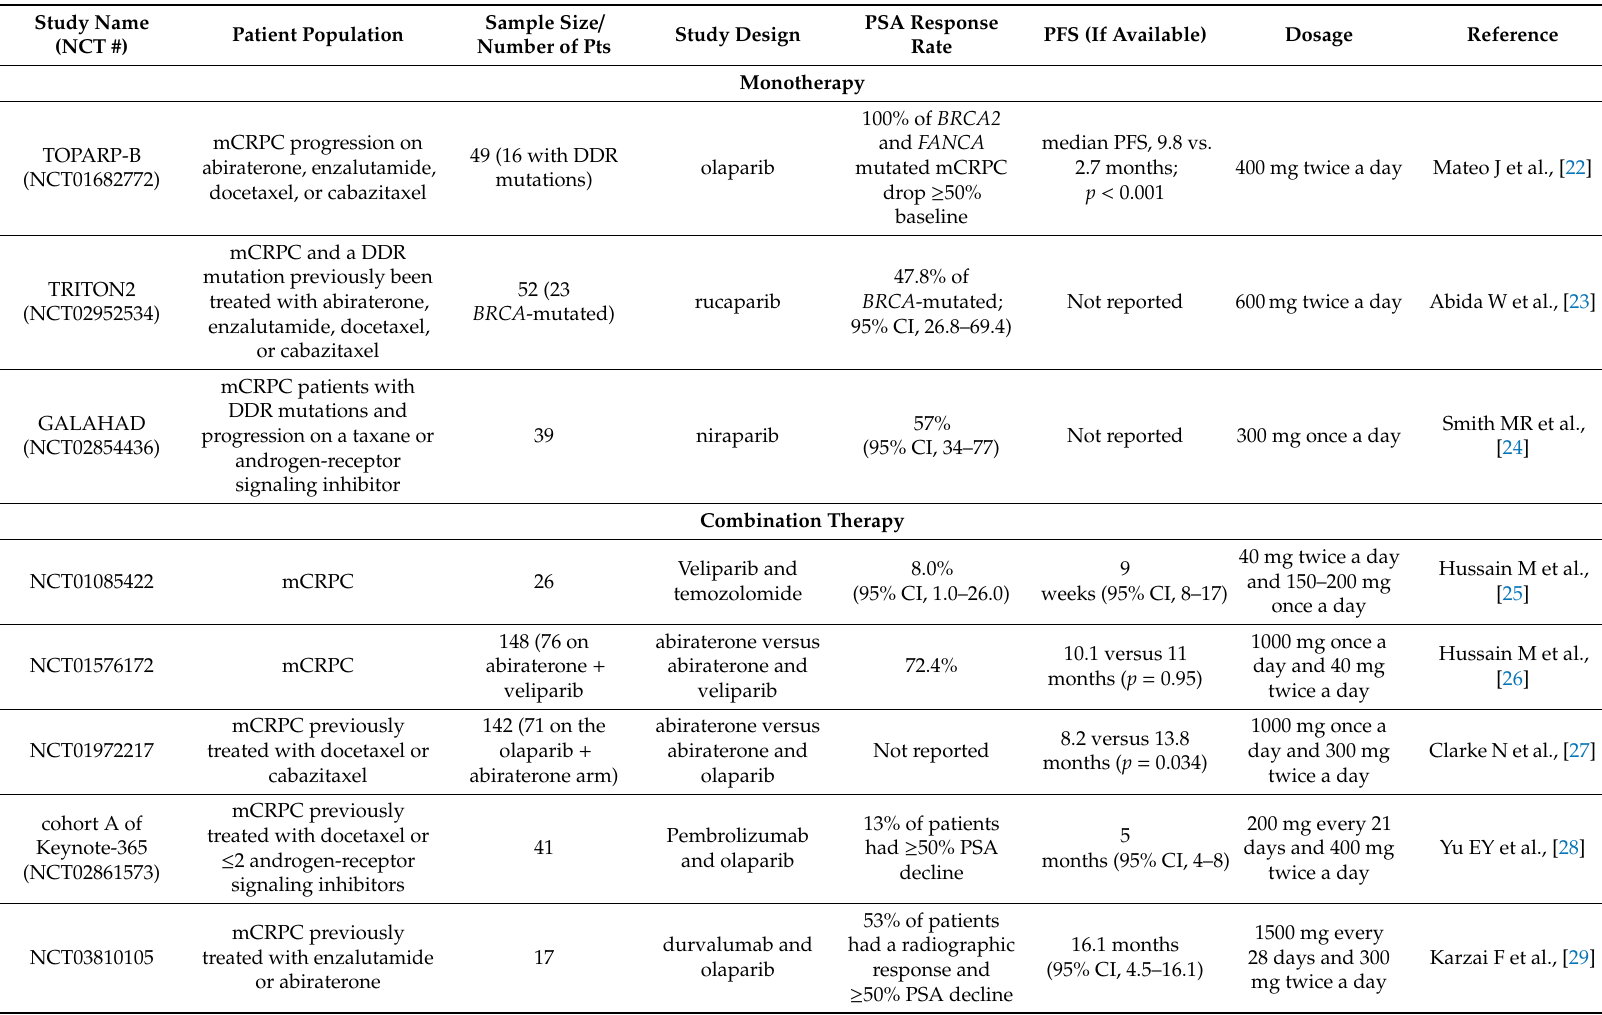
Table 2. Completed Phase II PARPi trials in prostate